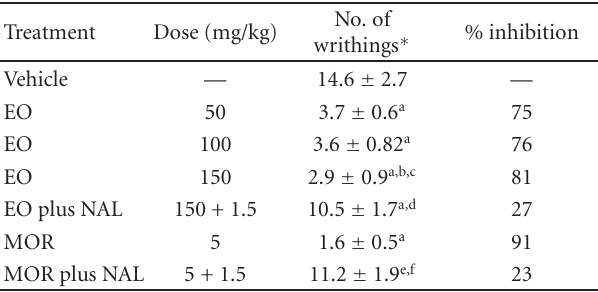
n = 7 per group. ∗ Values represent mean ±